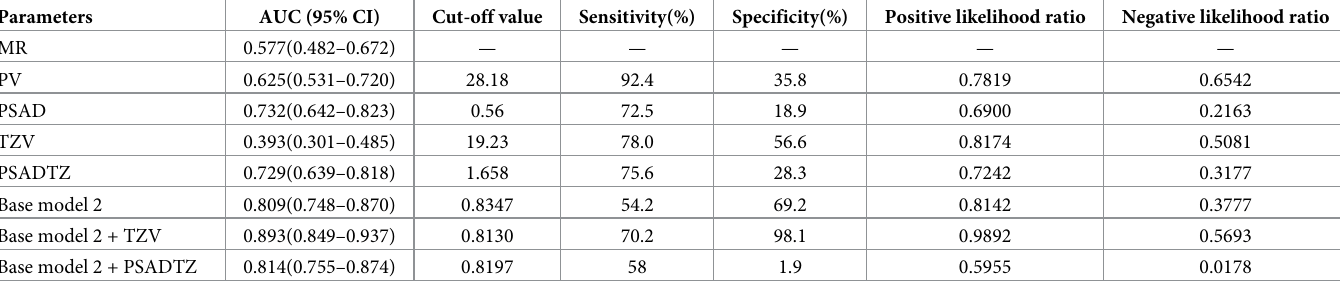
Table 6. The AUC and cut-off values for predicting biopsy outcome and their sensitivity, specificity, positive and negative likelihood ratios for HR-PCa and no HR-PCa.